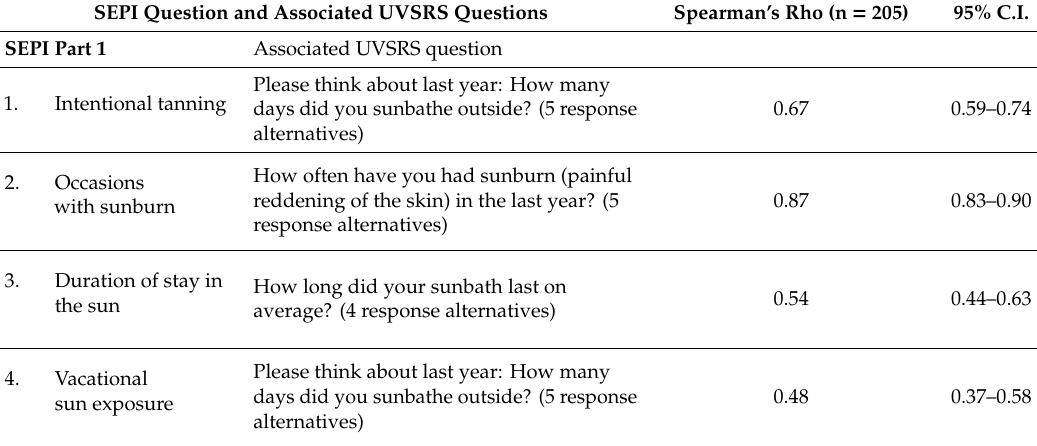
Table 3. Correlation between SEPI question responses and the associated question in the UVSRS questionnaire (in italics), by Spearman’s rho, and its 95% confidence intervals. The table also displays the number of response alternatives for each of the UVSRS